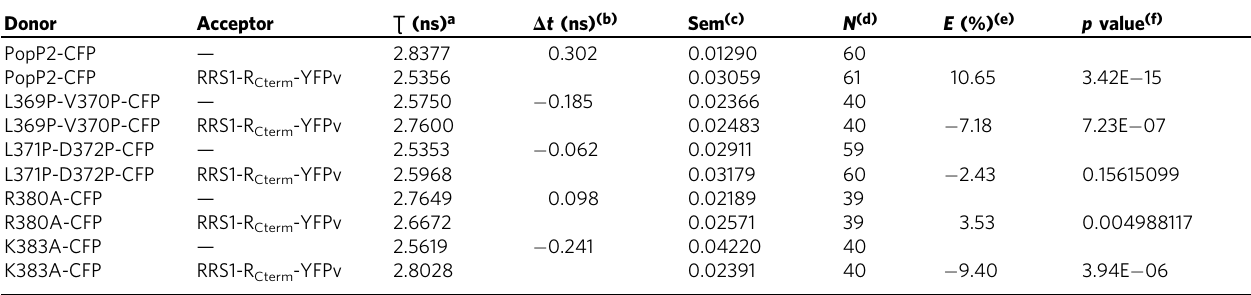
Table 1 FRET-FLIM measurements showing that PopP2 L369P/V370P, L371P/D372P, and K383A are affected in their ability to physically interact in planta with the C-terminal portion of